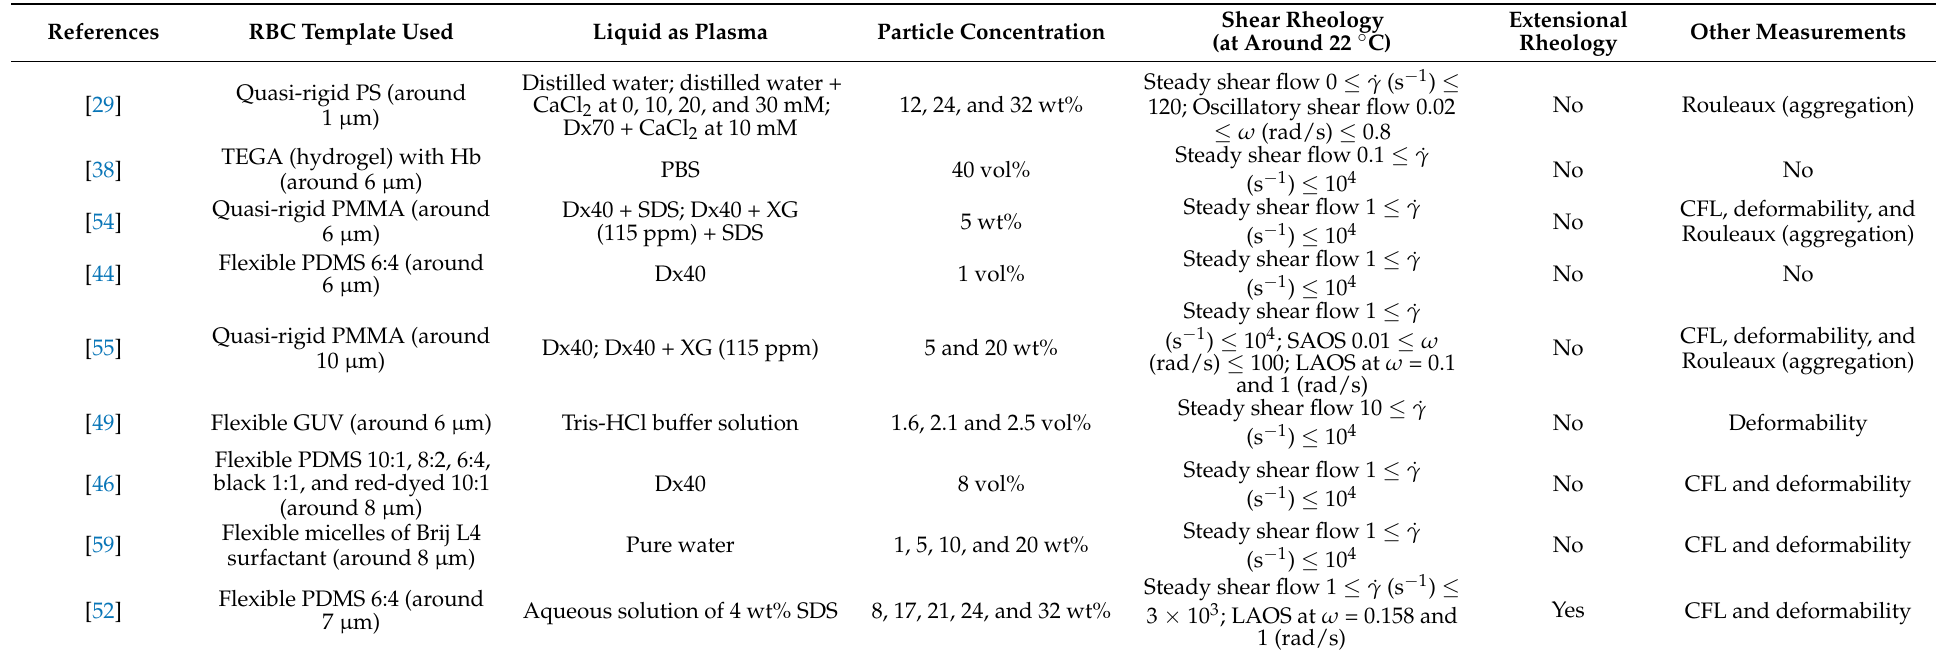
Table 2. Summary of blood particulate analogue fluids analyzed in the literature, including the rheological measuring